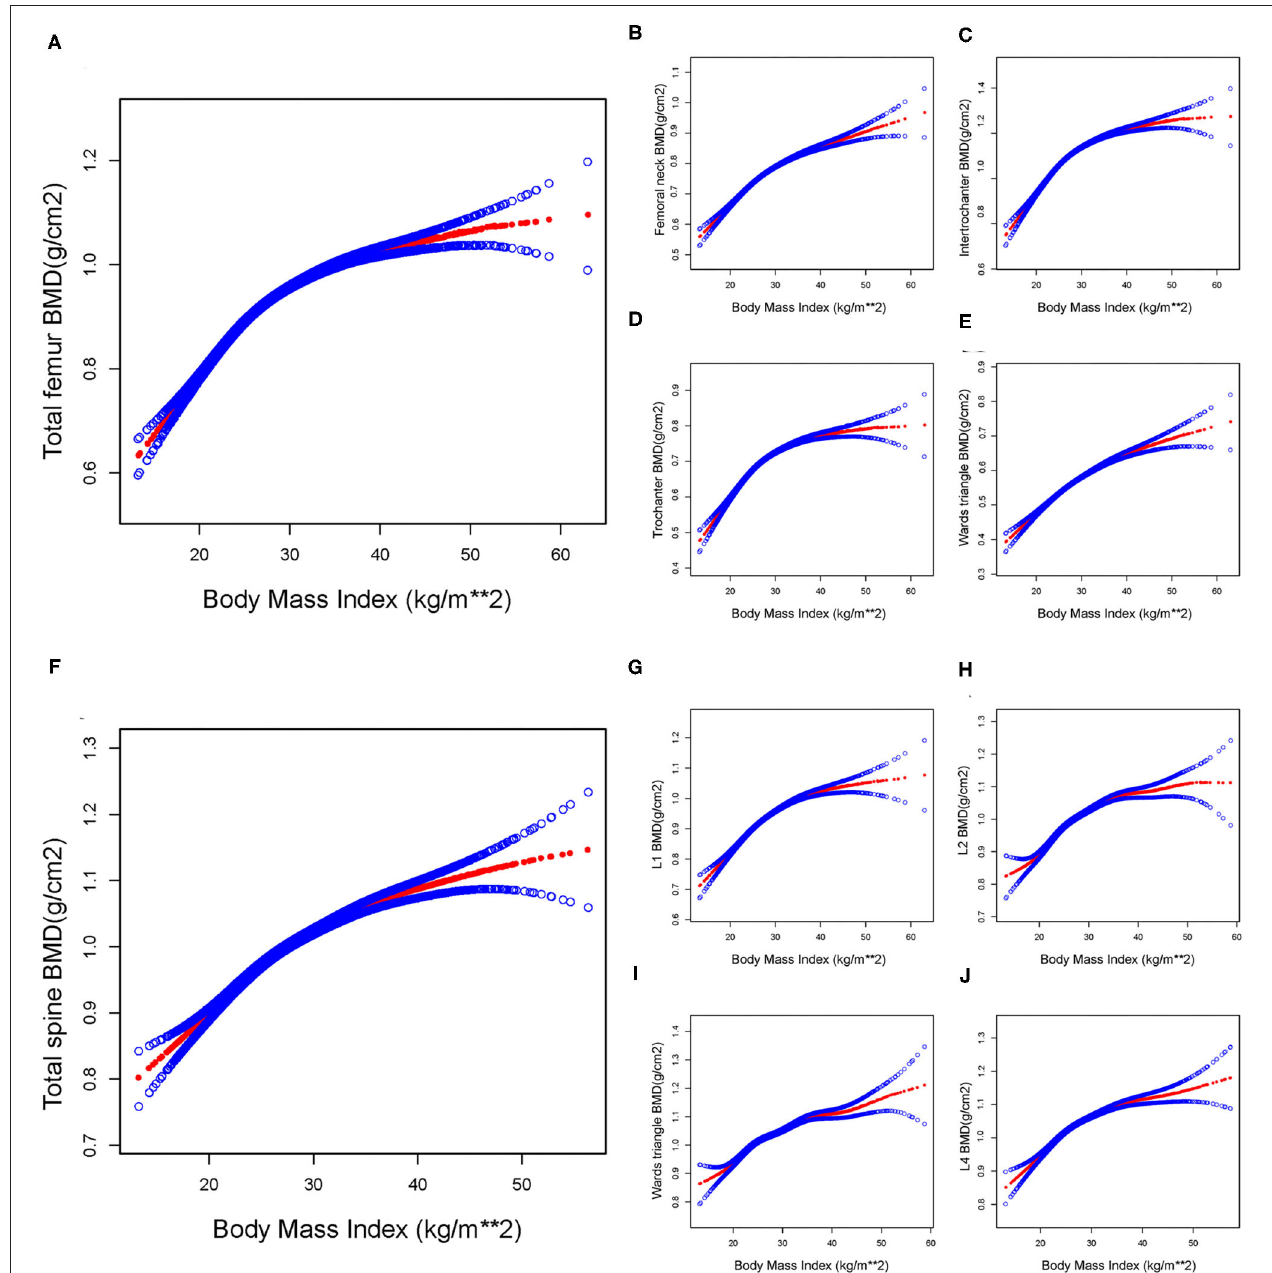
FIGURE 2 | The association between BMI and BMD in total participants. By saturation effect analysis, saturation values were found in all subgroups (Log-likelihood ratio test, P < 0.00 1 , respectively). (A) Total femur group, BMI saturation value = 26.13 (kg/m 2 ). (B) Femoral neck group, BMI saturation value = 26.59 (kg/m 2 ). (C) Trochanter group, BMI saturation value = 26.44 (kg/m 2 ). (D) Intertrochanter group, BMI saturation value = 26.06 (kg/m 2 ). (E) Ward triangle group, BMI saturation value = 29.60 (kg/m 2 ). (F) Total spine group, BMI saturation value = 26.82 (kg/m 2 ). (G) L1 group, BMI saturation value = 31.90 (kg/m 2 ). (H) L2 group, BMI saturation value = 30.89 (kg/m 2 ). (I) L3 group, BMI saturation value = 25.60 (kg/m 2 ). (J) L4 group, BMI saturation value = 25.60 (kg/m 2 ). The red line represents the β - value, and the blue line represents the 95% CI . Adjust for: Gender, Race, Age, Education level, Ratio of family income to poverty, Smoked at least 100 cigarettes in life, Moderate work activity, Albumin refrigerated serum, Globulin, Glucose refrigerated serum, Cholesterol refrigerated serum, Cholesterol Triglycerides, Standing Height, Arm Circumference, Waist Circumference. were not evident in the female participants, and saturation in total femur BMD and 26.84 (kg/m 2 ) in the total spine values for each femur and lumbar spine region varied in males participants. This was consistent with the results widely ( Supplementary Figure 2 obtained for the whole participants. However, saturation effects